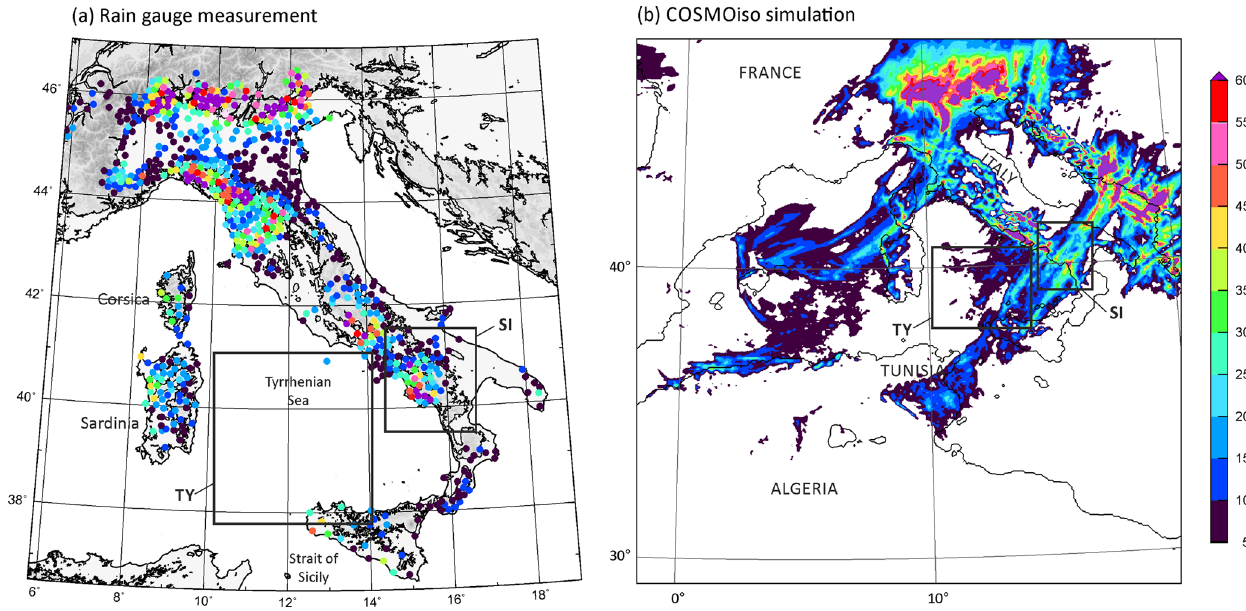
Figure 1. Accumulated precipitation during IOP 13 from 00:00UTC on 15 October 2012 to 03:00UTC on 16 October 2012 obtained from (a) the rain gauge network and (b) the COSMOiso